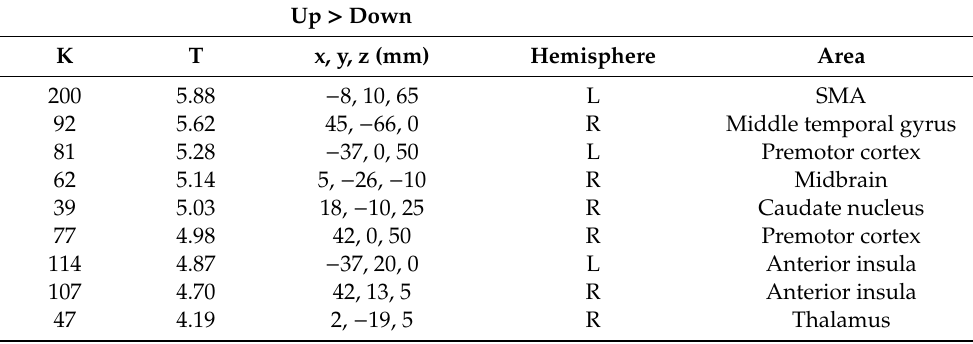
Table 1. BOLD activations during all real-time fMRI-based emotion regulation runs. The statistical threshold was set at p < 0.001 cluster level corrected using probabilistic threshold-free cluster enhancement